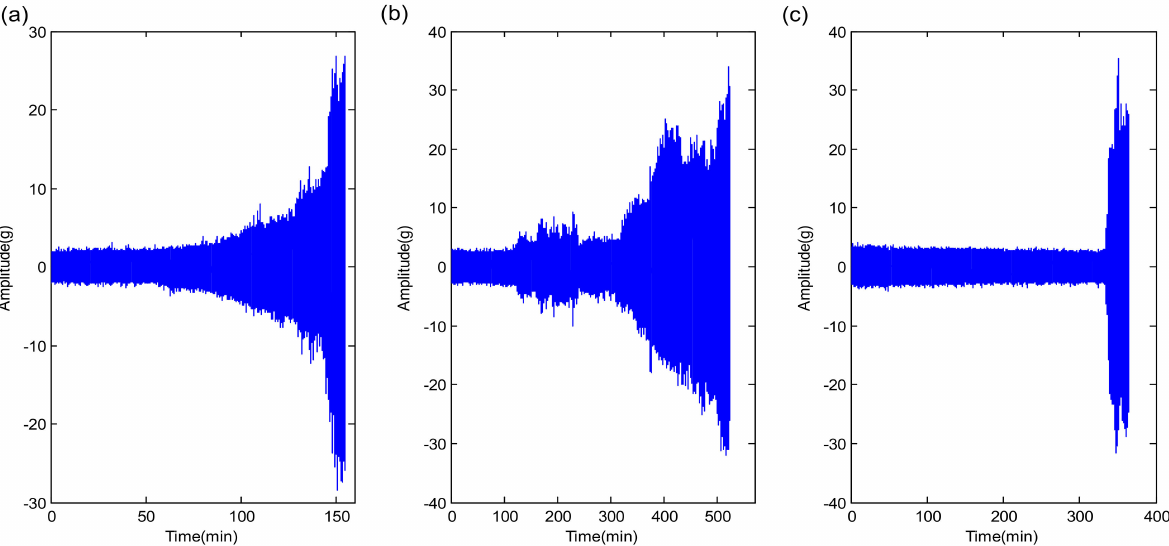
Figure 13. The temporal waveforms of whole-life signals in XJTU-SY dataset. ( a ) bearing1_3; ( b ) bear- ing2_3; ( c ) bearing3_3.